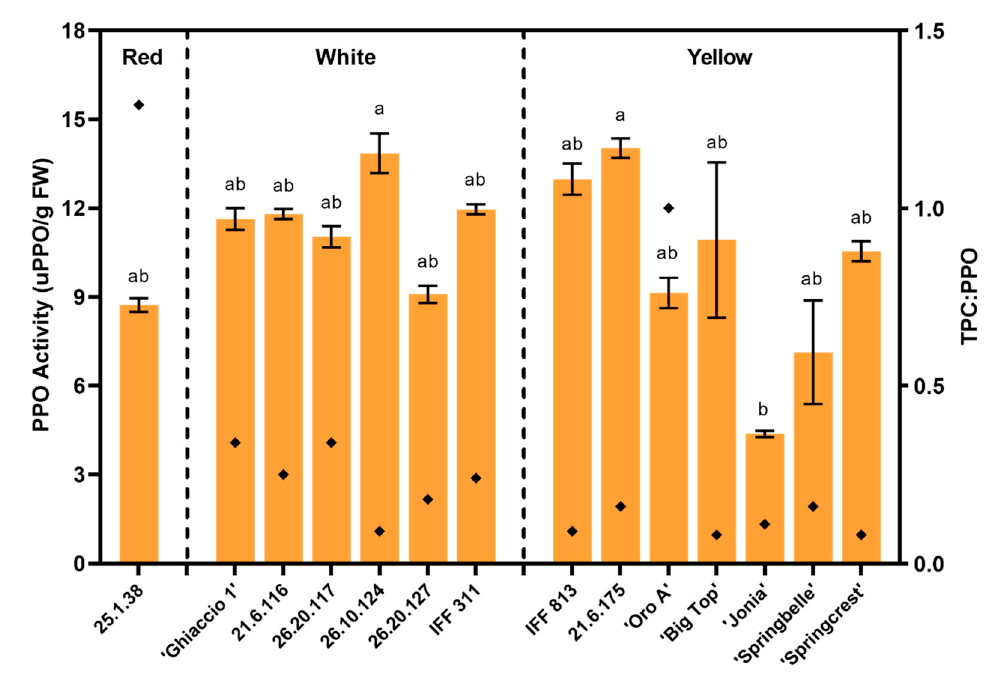
Figure 2. Polyphenol oxidase (PPO) activity (orange columns, primary y -axis) and the ratio of total phenolic concentration (TPC):PPO (black diamonds, secondary y -axis) at harvest in 2007 for all commercial cultivars and breeding accessions divided by flesh color. Tukey (HSD) test for post-hoc mean comparisons. Columns with the same letter above indicate non-significance at p < 0.05. Means ± S.E. displayed. No statistics are presented for the TPC:PPO ratio.